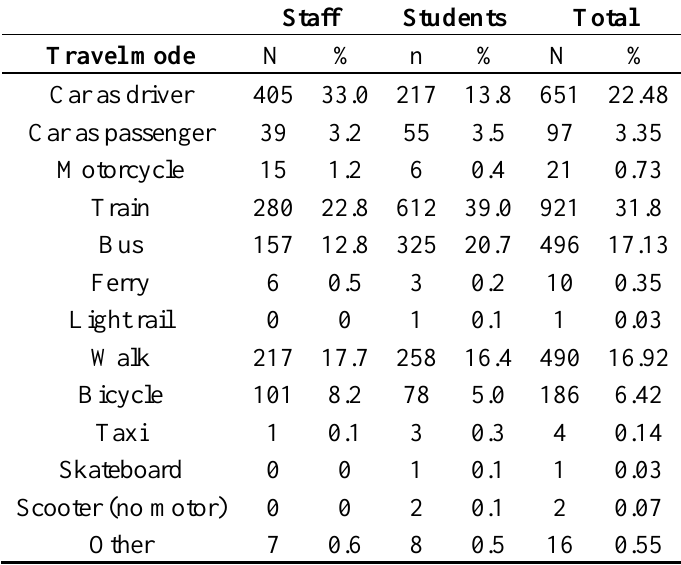
Table 2. Travel mode to University campuses.